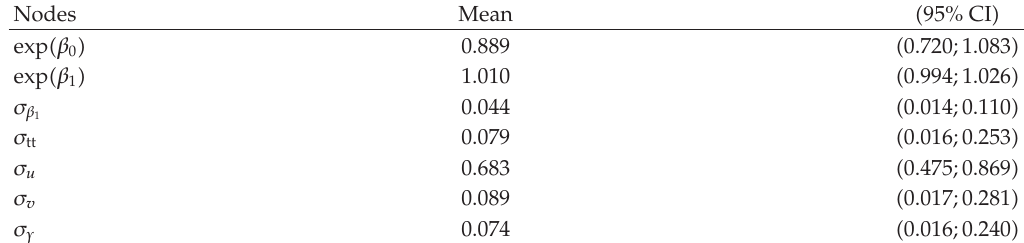
Table 2: Posterior mean estimates of parameters from the FB